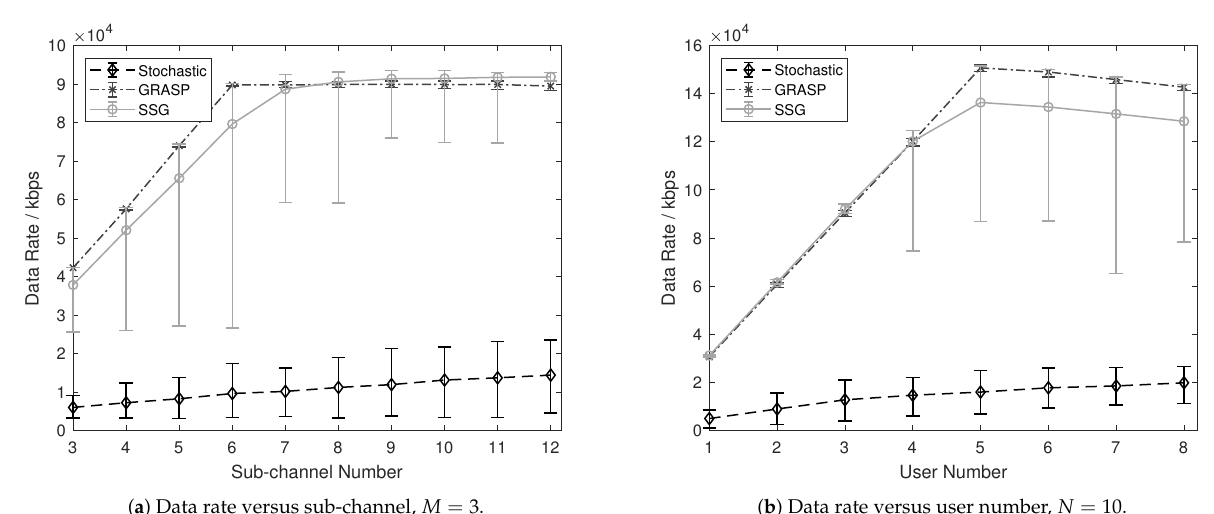
( b ) Data rate versus user number, N = 10. Figure 2. Performance comparison with error bars where α = 0.8 and ρ =